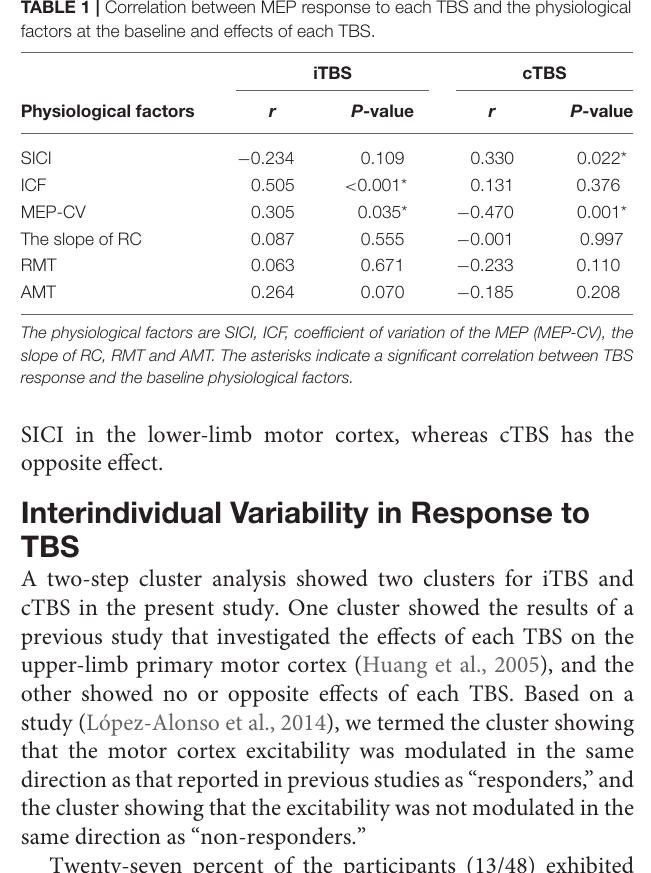
FIGURE 3 | Effects of TBS on short-interval intracortical inhibition and intracortical facilitation. The values of short-interval intracortical inhibition (%) (A) and the values of intracortical facilitation (%) (B) are normalized to the amplitude of test MEP at each time point. White box plots, iTBS; light gray, cTBS; dark gray, sham iTBS. Median and interquartile ranges are represented by horizontal lines within boxes and whiskers (representing minimum and maximum values), respectively. The asterisk denotes significant differences between Pre and each time point within the conditions. The dagger denotes significant differences between each condition at each time point ( P < 0.05).